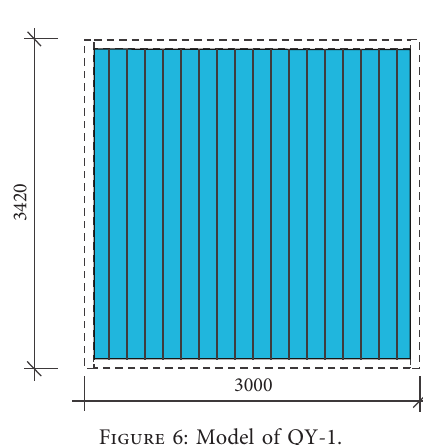
Figure 5: Model of QX-2.